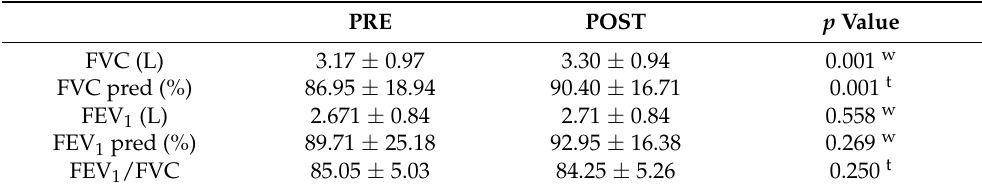
Table 3. Spirometric characteristics in COVID-19 participants before and after a pulmonary rehabili- tation